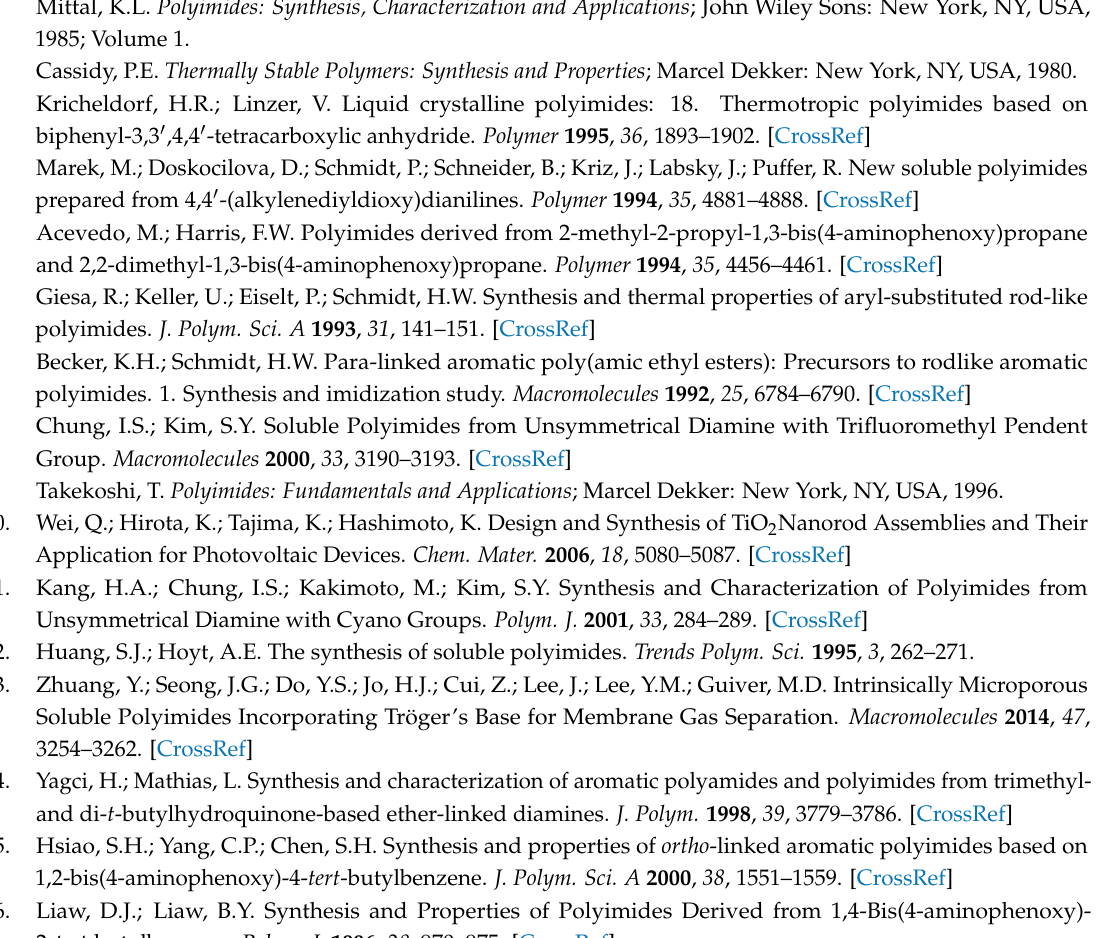
Figure S1: 1 H NMR characterization for 4ACA salt; Figure S2: 1 H NMR characterization for 4ATA salt; Figure S3: 1 H NMR characterization for 4ATA methyl ester salt; Figure S4: 1 H NMR characterization for 4ATA methyl ester; Figure S5: FTIR characterization peak assignments for the prepared poly(amic acid) and polyimide; Figure S6: FTIR characterization for the prepared polyimide with characteristic peaks shown in vertical bands; Figure S7: WAXD pattern for the synthesized biopolyimides; Figure S8: TGA curves for the synthesized biopolyimides; Figure S9: DSC curves for the biopolyimides; Figure S10: Optical transparency of the synthesized biopolyimides; Biopolyimide Solubility Equation see